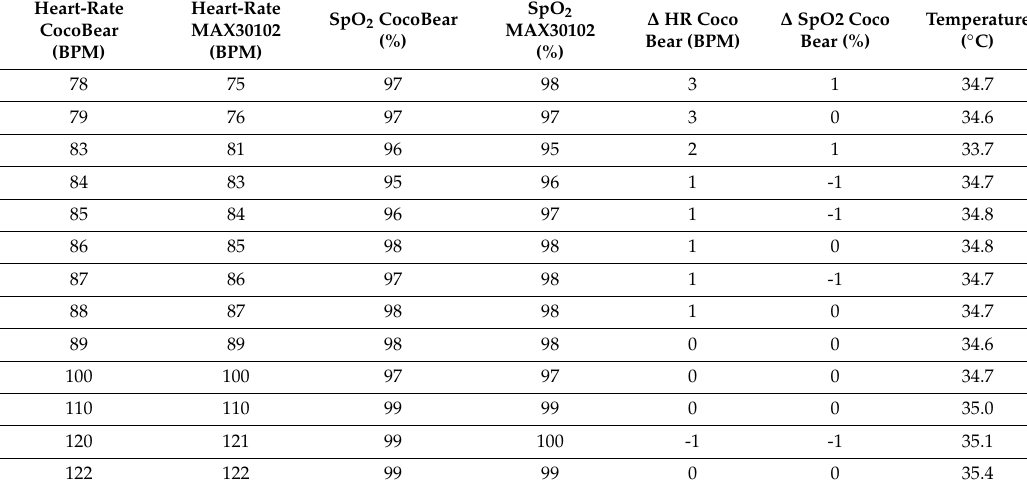
Table 5. Detected heart rate (HR) and blood oxygenation (SpO 2 ) values using the CocoBear oximeter and the MAX30102 sensor; di ff erences reported in the fifth and sixth column are between HR and SpO2 values supplied by CocoBear and MAX30102 devices; also the skin temperature acquired by the MAX20102 sensor is